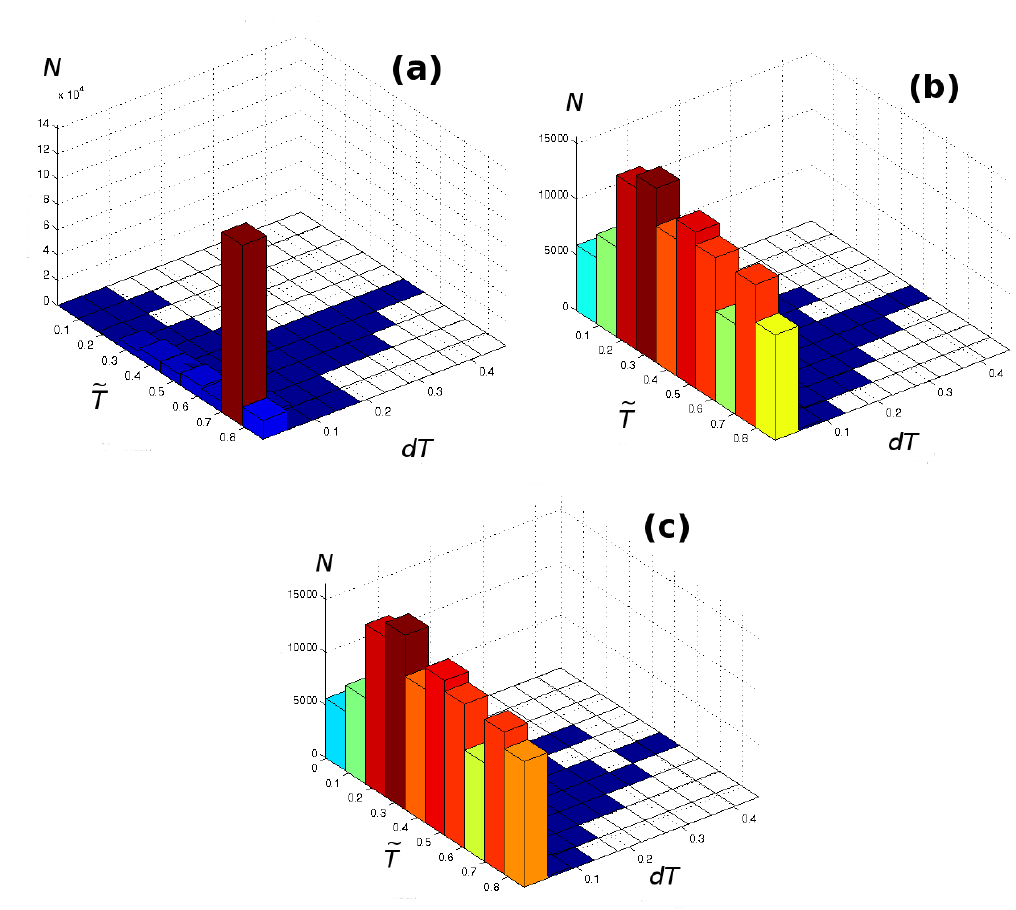
Figure 7. Plot of the Markov matrices, i.e. , histograms of the number of cycles N as a function of the mean value of every load cycle, ˜ T , and the cycle amplitude itself ∆ T for: ( a ) the torque measurements of AV4; ( b ) the torque measurements of AV5; and ( c ) the torque estimates of